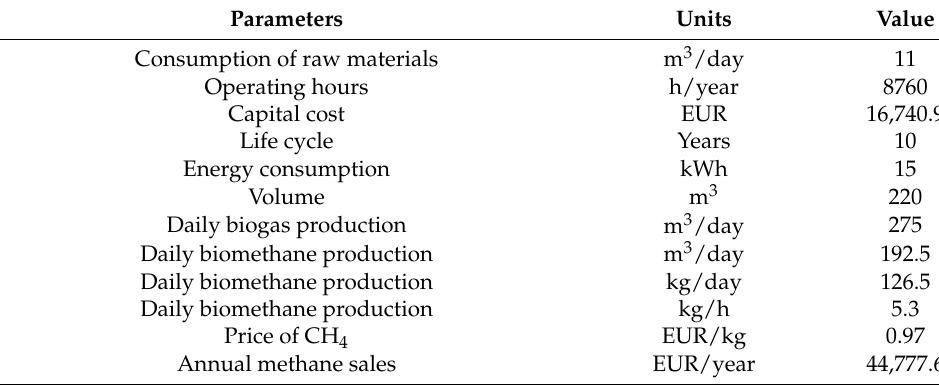
Table 6. Initial assumptions for the anaerobic digestion unit.